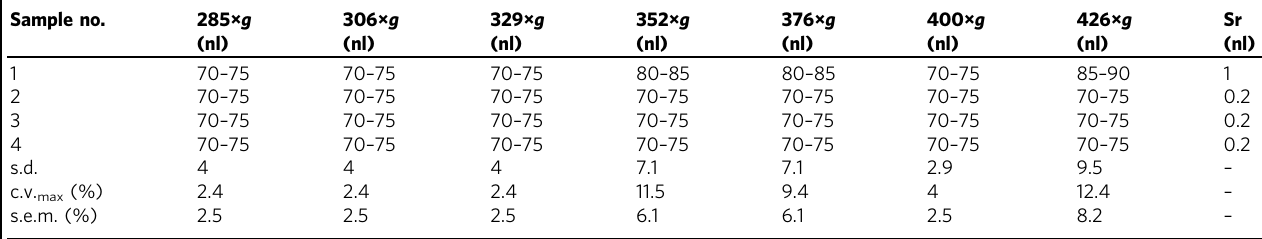
Table 1 Micro-dispenser dispensing accuracy in lab-on-a-disc platforms Sample no.